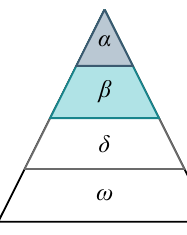
Figure 1. Grey Wolf